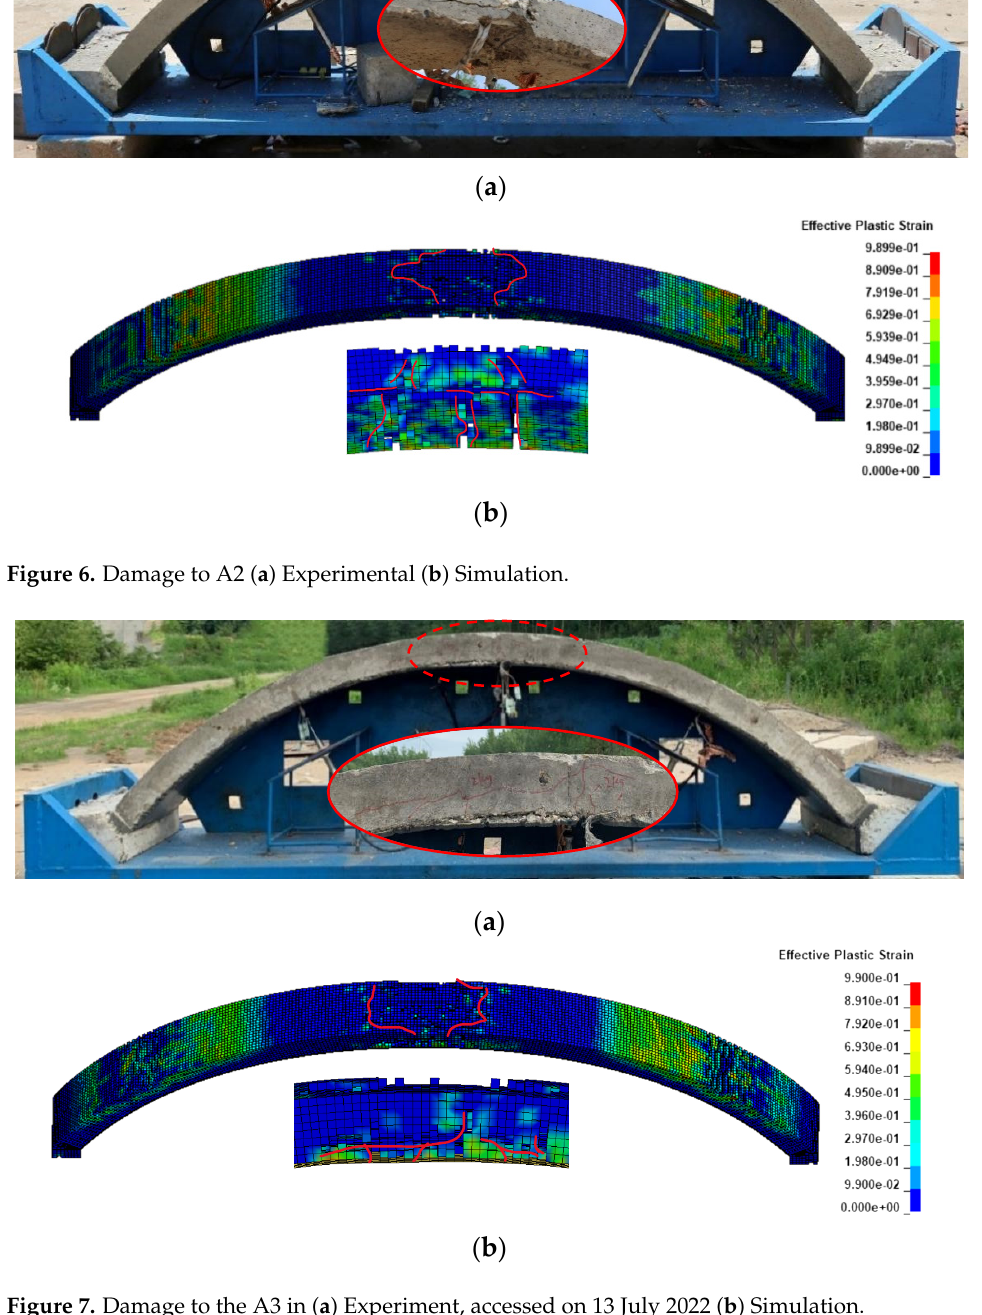
Figure 7. Damage to the A3 in ( a ) Experiment, accessed on 13 July 2022 ( b ) Simulation.